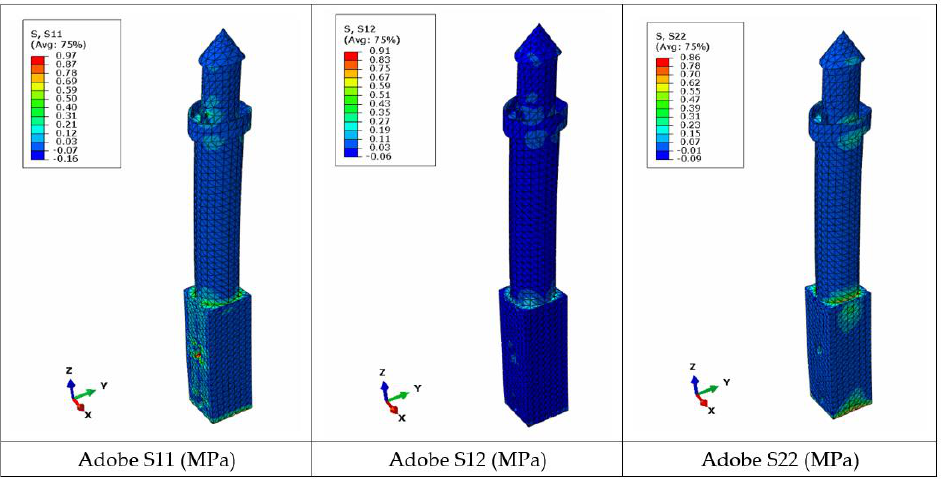
Figure 14. Stress diagrams for adobe (H = 25.40 m).